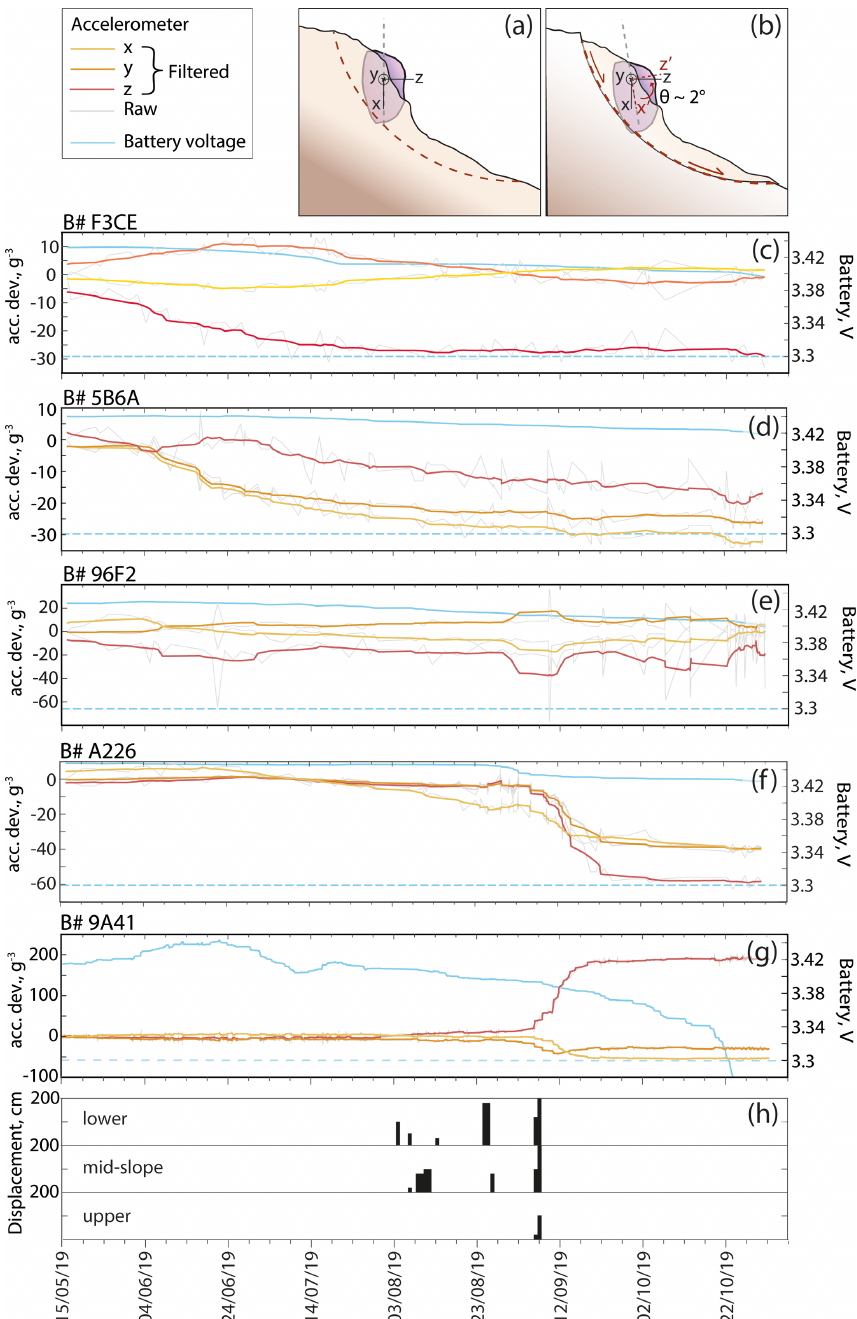
Figure 5. (a–b) Sketch of the possible type of movement experienced by embedded and partly embedded boulders. Note that this is only a schematic to indicate a movement that occurs in accordance with the landslide body and does not necessarily represent real movement of the boulders monitored in this study. (c–g) Real accelerometer data (raw and smoothed) showing deviation from the initial position for each axis for boulders within the landslide body through the monsoon season. The yellow, orange, and red curves in the line plots represent the smoothed data from the accelerometer x , y , and z axes, respectively, and the grey curves represent the raw data for each axis. The blue curve shows the battery voltage, and the blue horizontal dashed line represents the 3.3V threshold below which the battery is discharged and faulty behaviour may be expected. (h) Estimated displacements of lower, mid-slope, and upper parts of the slope obtained through field camera